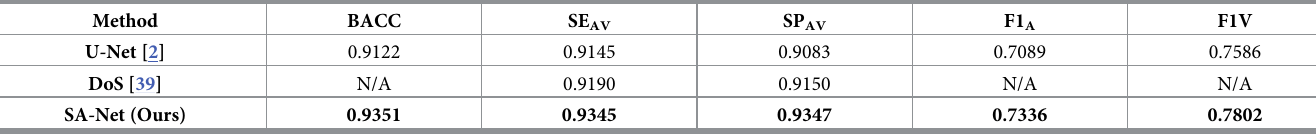
Table 3. Performances of different A/V classification methods on DRIVE